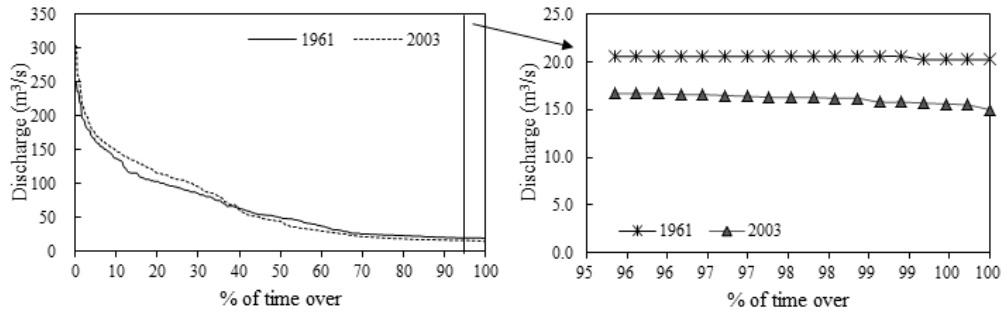
Figure 13. An example of flow duration curve for the paired years 1961 and 2003 during the hydropower dam disturbance period (flow duration curves for other selected pairs in disturbed period can be found in Figure A4).